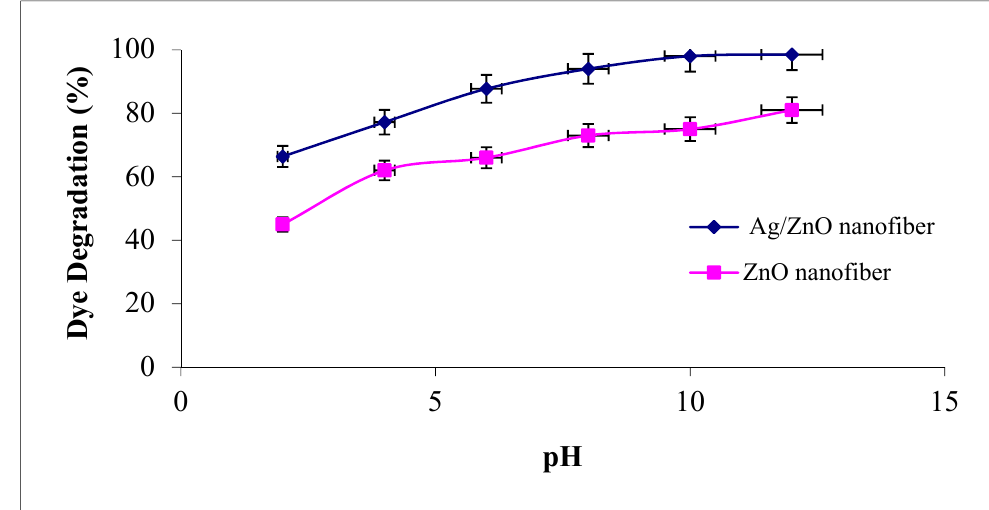
Figure 9. Effect of dye solution pH on the MG dye photocatalytic degradation process using ZnO polymeric nanofibers after and before silver immobilization (initial dye concentration = 20 ppm, nanofiberdose = 0.1 g, contact time = 60 min at room temperature).